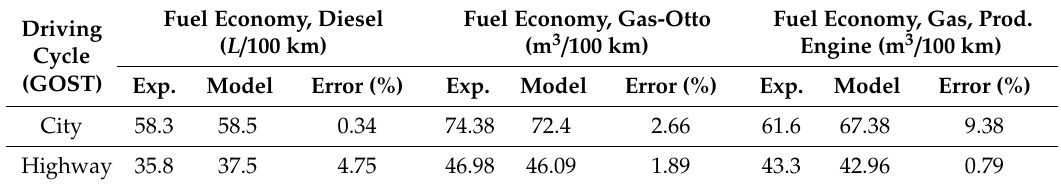
Table 7. Comparison between the experimental and calculated fuel economy for the vehicles equipped with the conventional